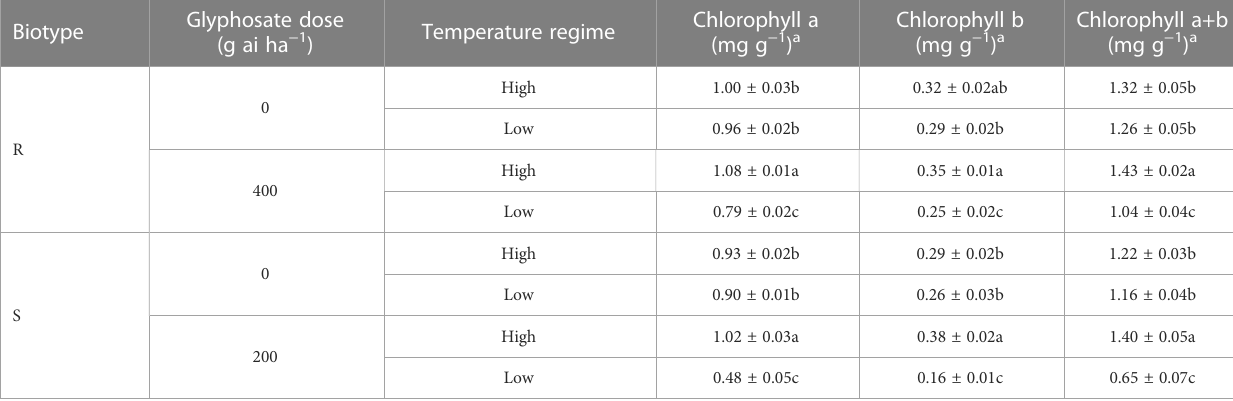
TABLE 2 In fl uence of glyphosate on leaf chlorophyll content of glyphosate-resistant (R) and -susceptible (S) Eleusine indica plants grown under high temperature (30°C/25°C day/night) and low temperature (20°C/15°C day/night) regimes.